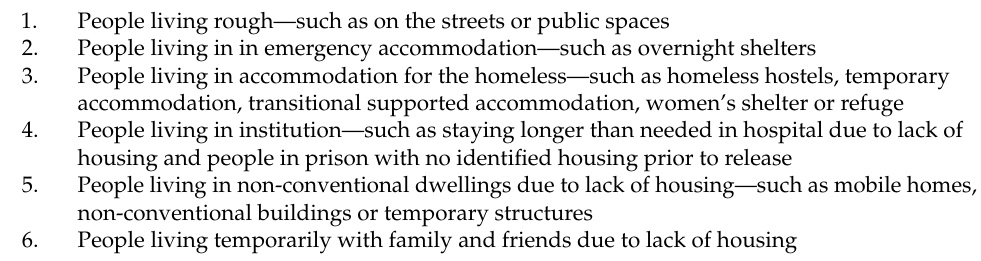
Table 1. Categorisations of homelessness (FEANTSA 2018)